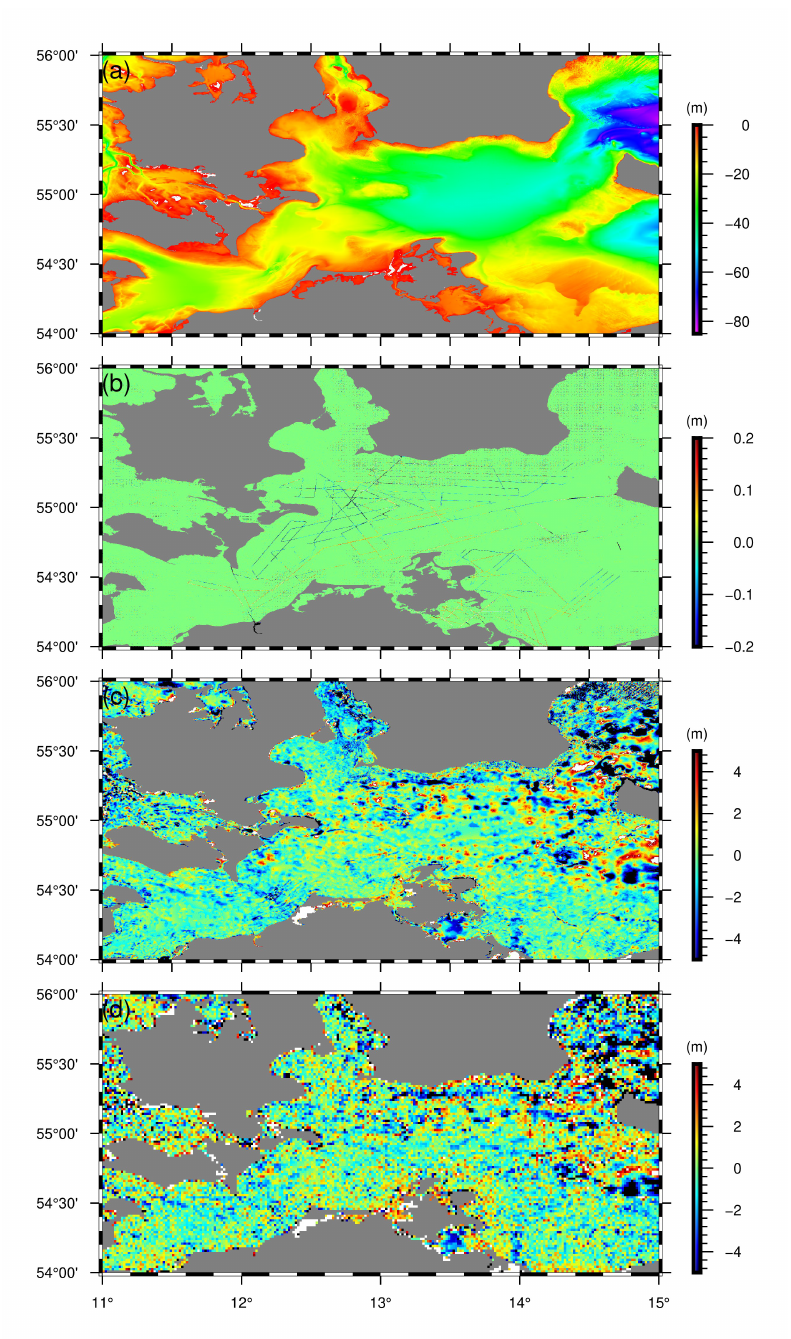
Figure 7. Seafloor topography: ( a ) the estimated model; ( b – d ) are differences between our estimated model and EMODnet model, SRTM model and SIO model,